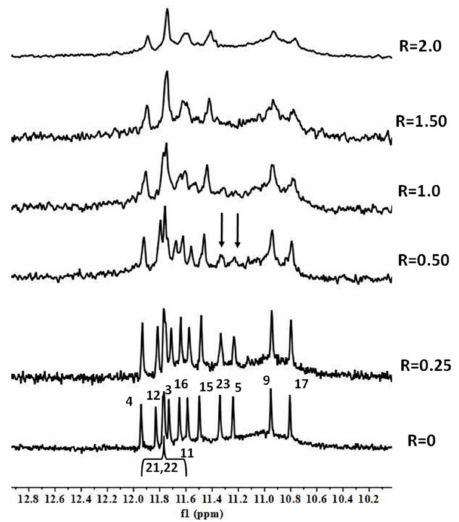
Figure 8. Imino proton region of 1D NMR titration spectra of TP3-T6 with BA41 at 25 ◦ C at different R = (drug)/(DNA) Figure 8 . Imino proton region of 1D NMR titration spectra of TP3- T6 with BA41 at 25 °C at different R = (drug)/(DNA) ratios.